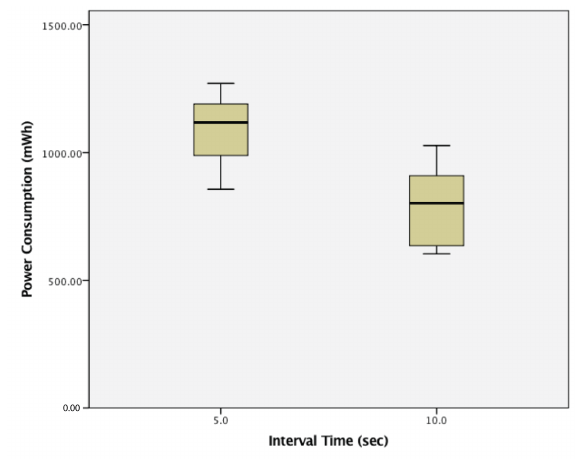
Figure 17. Power consumption of clusters of passive wireless sensor nodes with 5 s vs. 10 s transmission